Question: What style of plot is this figure drawn as?
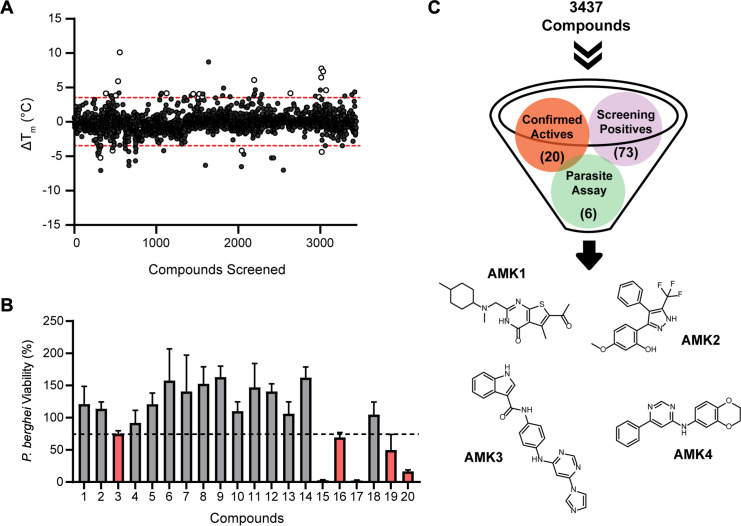
Answer: bar